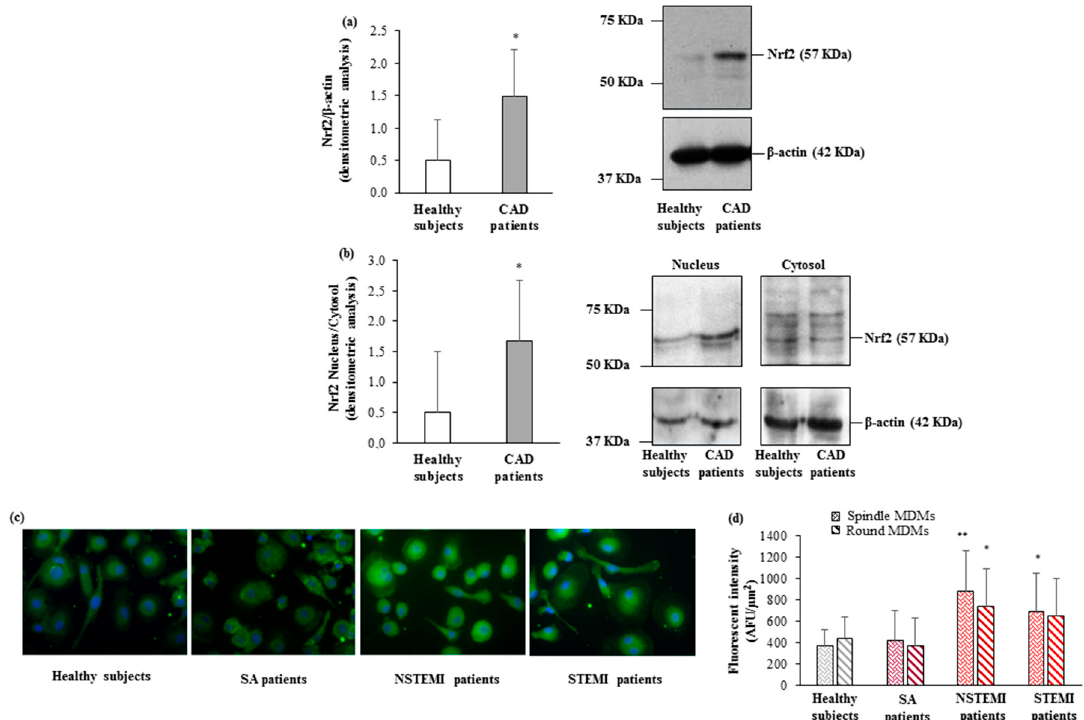
Figure 3. Nrf2 levels in CAD patients and healthy subjects. ( a , b ) Nrf2 levels in ( a ) total cellular lysate, ( b ) nuclear and cytosolic compartments were detected by western blot analysis. β -actin was used as a control of protein loading. Densitometry is shown in the bar graph. Data are expressed as mean ± SD and derive ( a ) from MDMs obtained from 10 healthy subjects and 17 CAD patients; ( b ) from MDMs obtained from 5 healthy subjects and 5 CAD patients. ( c ) Representative images of Nrf2 in round and spindle MDMs obtained from healthy subjects and CAD patients (400 × original magnification), nuclei were visualized by Hoechst 33258. ( d ) Quantitative analysis of Nrf2 in round and spindle MDMs. Data are expressed as mean ± SD of fluorescence intensity / µ m 2 (at least three fields, 400 × magnification, were analyzed) and derive from independent cultures obtained from 10 healthy subjects and 30 CAD patients (SA n = 10; NSTEMI n = 10; STEMI n = 10). * p < 0.05, ** p < 0.01, vs. healthy subjects.